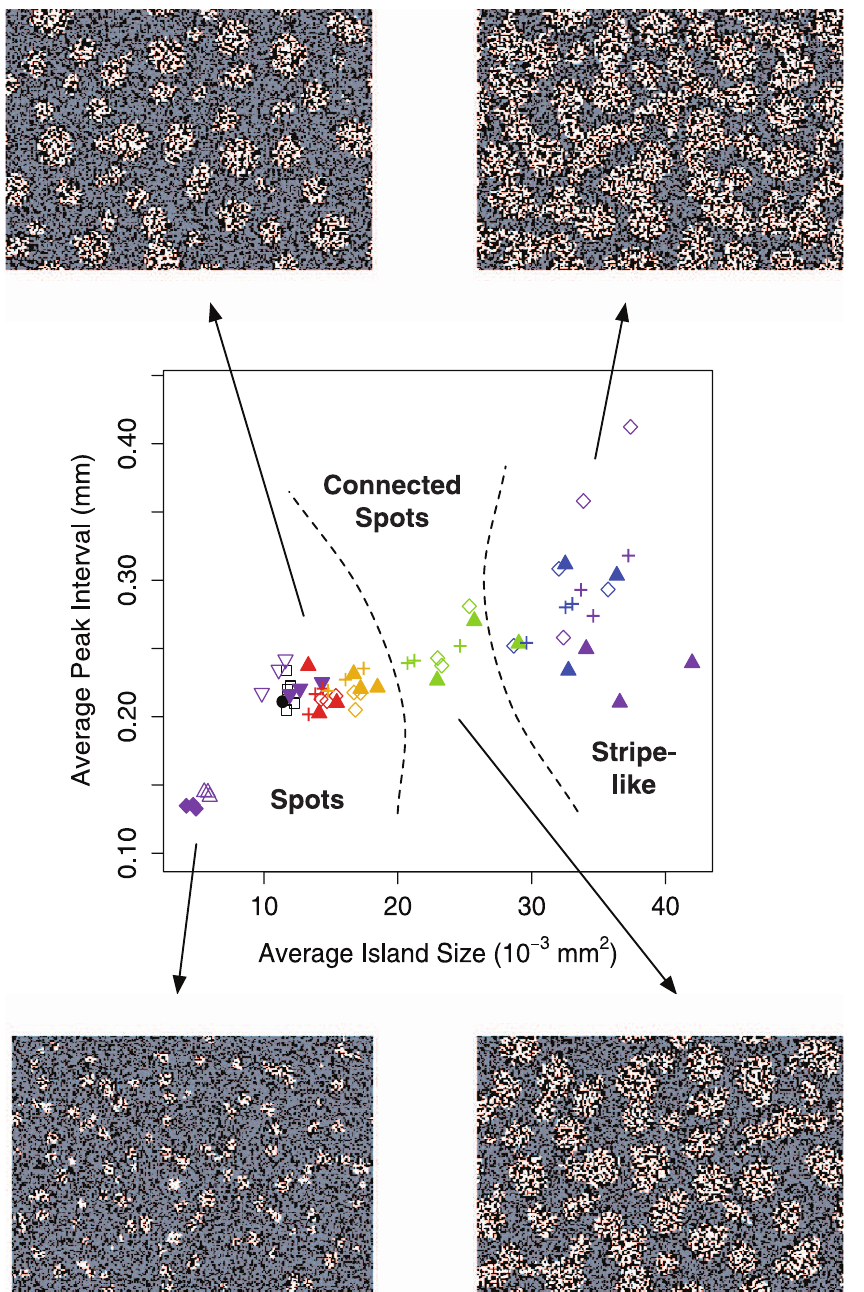
Figure 5. Variation in Some of the Key Parameters Induces Morphological Changes in the Resultant Spatial Patterns from Distinct Spots to Connected Spots to Stripe-Like Patterns Average peak interval versus average island size for variations in the some of the key parameters are shown: þ 5% (diamond) and (cid:2) 5% (filled diamond) for k 1 , þ 5% (triangle) and (cid:2) 5% (filled triangle) for k 3 , þ 5% (inverted triangle) and (cid:2) 5% (filled inverted triangle) for k 2 , and þ 5% ( þ ) for k 4 . The colored points are a gradient of variations: 1% (red), 2% (orange), 3% (green), 4% (blue), and 5% (violet). Also shown are the five simulations (square) using the standard parameter values in Table 2 and the mean for the 12 experiments (circle). All simulations were run for 3,000 iterations with periodic boundary conditions.